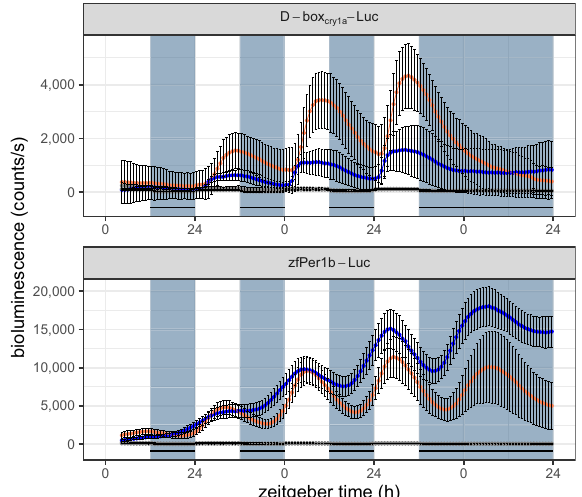
Figure 3. Luciferase assay showing rhythmic bioluminescence of Amphiprion ocellaris EAO (orange) and zebrafish PAC-2 cells (blue) transfected with D-box Cry1a -Luc (above) or zf Per1b -Luc (below) constructs. A negative control of non-transfected cells is shown in grey. For each condition, the mean of eight independently transfected wells and standard deviation is shown. Cells were exposed to a 12:12 h LD cycle, indicated by bluish- grey background and black stripes. Both cell lines, transfected with zf Per1b -Luc showed a comparable robust daily rhythm, even under DD. Cells transfected with D-box Cry1a -Luc were only rhythmic during the LD